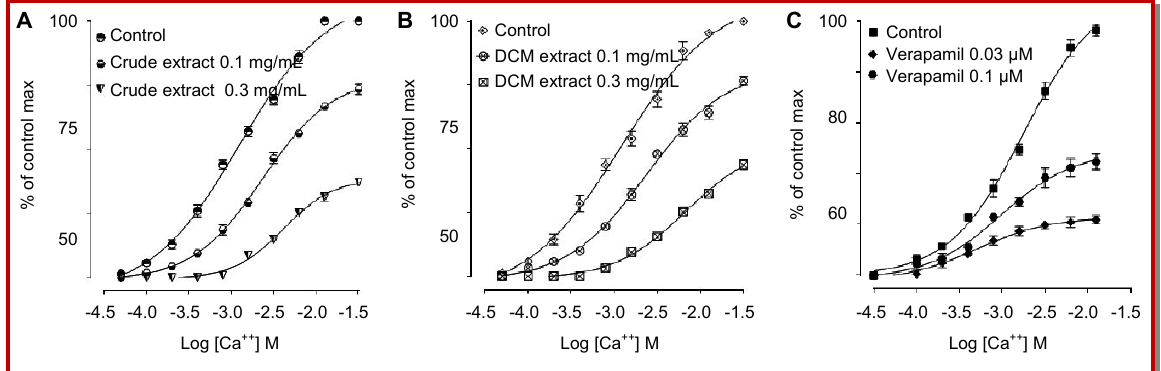
Figure 2: Ca ++ concentration response curves (CRCs) in the presence of increasing concentrations of crude extract (A), DCM extract (B) and verapamil (C) respectively in isolated rabbit jejunum preparations. Values shown are mean ± S.E.M